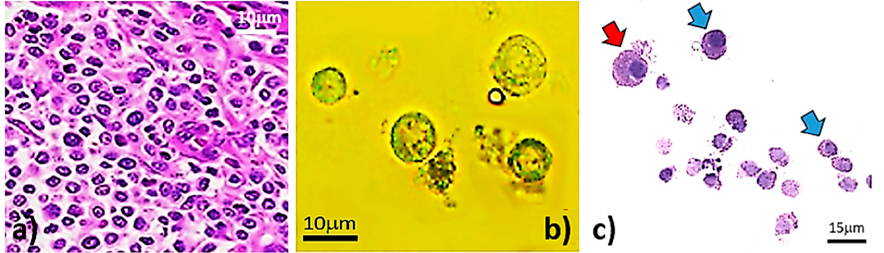
Figure 3. Normal configurations of unsorted MCT cells. ( a ) Histopathology of MCT hematoxylin